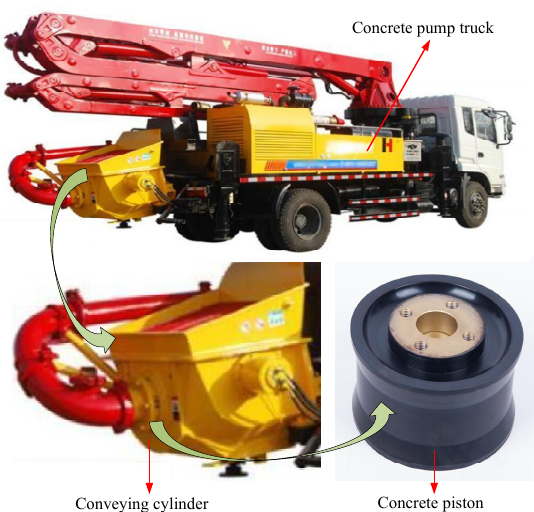
Figure 1. Concrete pump truck and concrete piston.